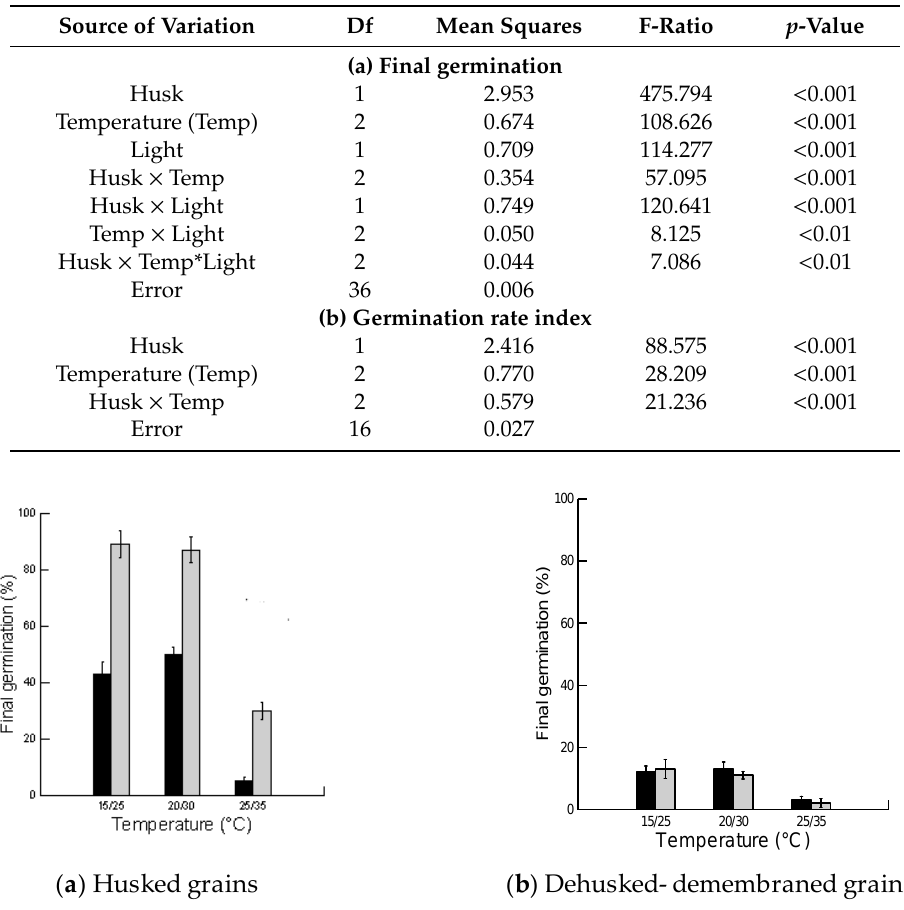
Figure 2. Effects of light and temperature of the incubation on final germination percentage (mean ± SE) of husked and dehusked-demembraned grains of Brachypodium hybridum . The grains were soaked for 24 h before germination in three programmed growth chambers. Dark and light bars are for dark and light germination, respectively. The mean of each treatment is from four replicate dishes, each with 20 seeds.